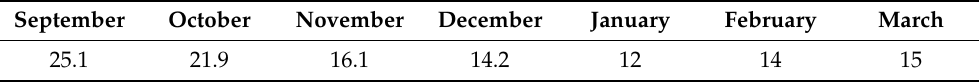
Table 2. Temperature media ( ◦ C) outside the greenhouse in tomato